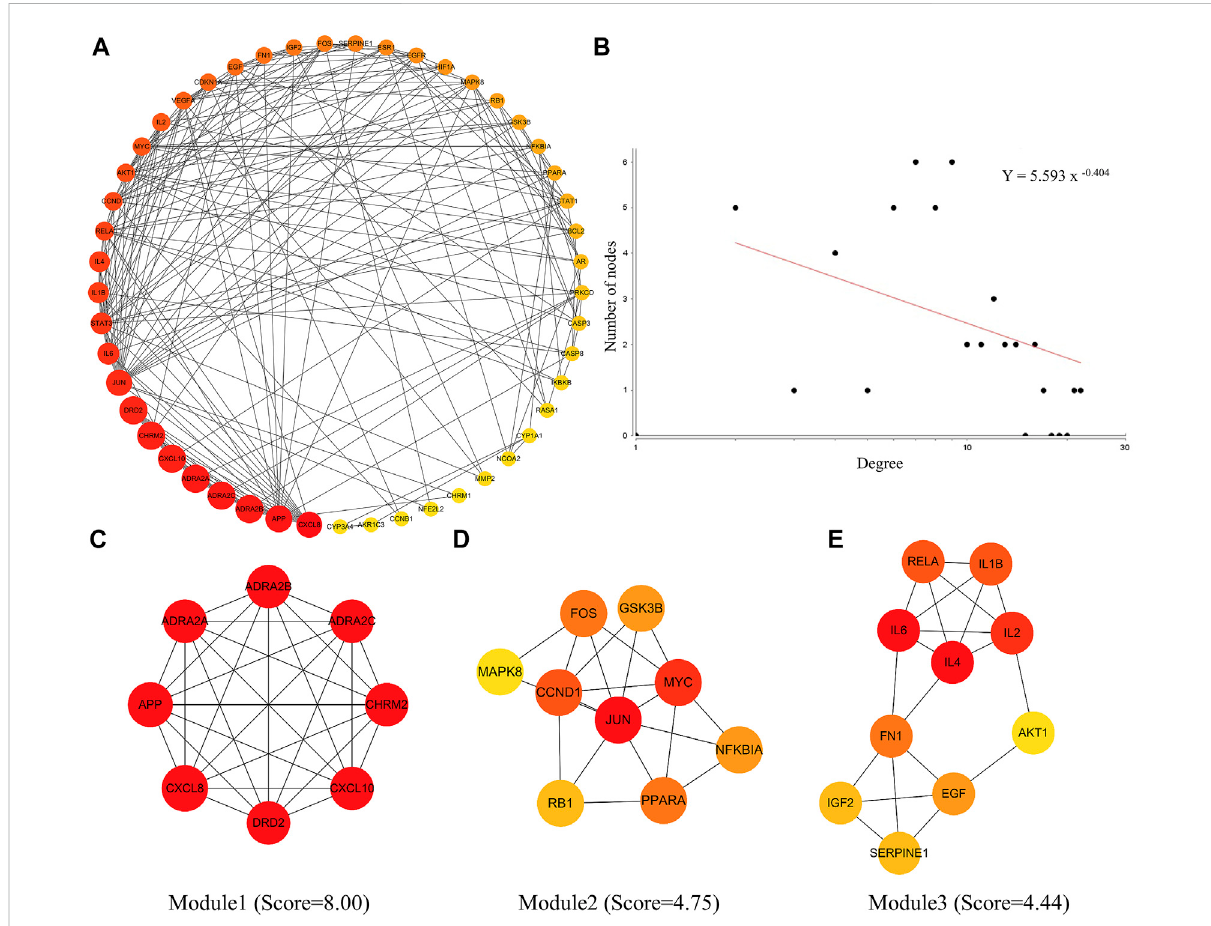
FIGURE 2 Protein interaction network (PIN) construction and network topology analysis. (A) PIN was constructed using the common host targets of LHQWandQFPD. (B) PINtopologyanalysiswasperformedusingtheNetworkAnalyzeroftheCytoscapesoftware. (C – E) Thesigni fi cantmodulewas identi fi ed from the PIN using the molecular complex detection (MCODE) method with a score > 4.0; the red and yellow nodes represent hub genes, yellow represents the lower degree and red represents the higher